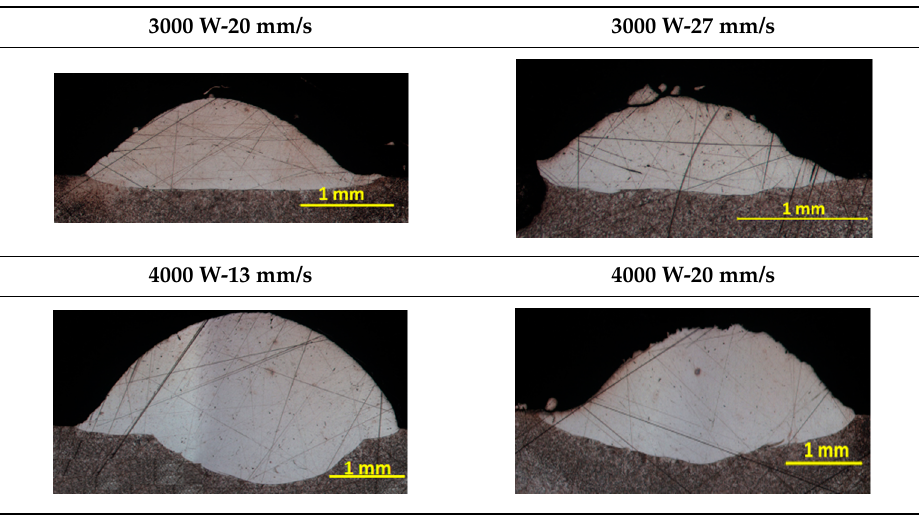
Figure 6. Micrograph of cross sections of a wall and a detail of bonding zone. It is worth mentioning that, due to the setup employed to manufacture this piece, it was difficult to maintain a homogeneous height in the whole contour, especially near the turning radius, because of the deceleration of the machine axes before reaching these points. This can be observed in